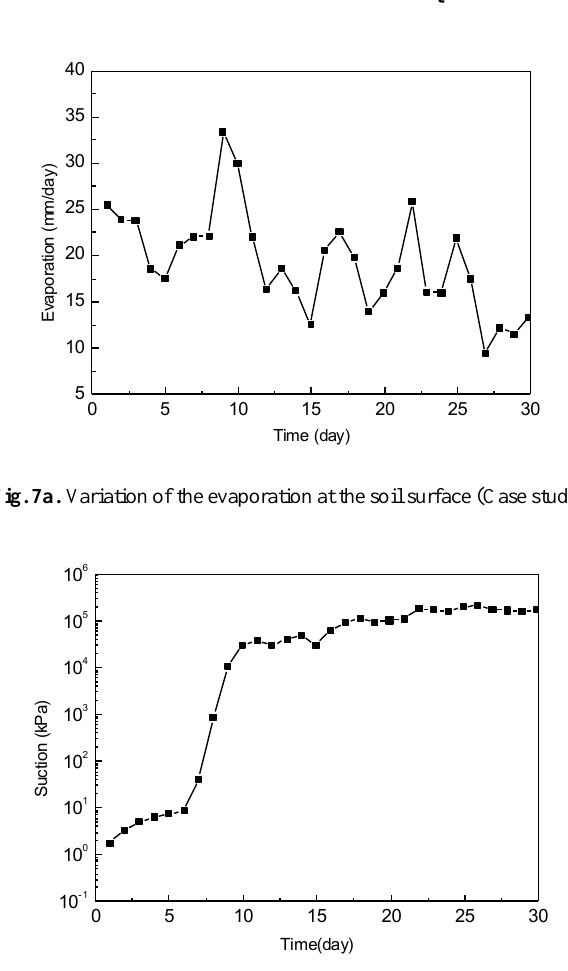
Figure 7c. Variation of the soil permeability